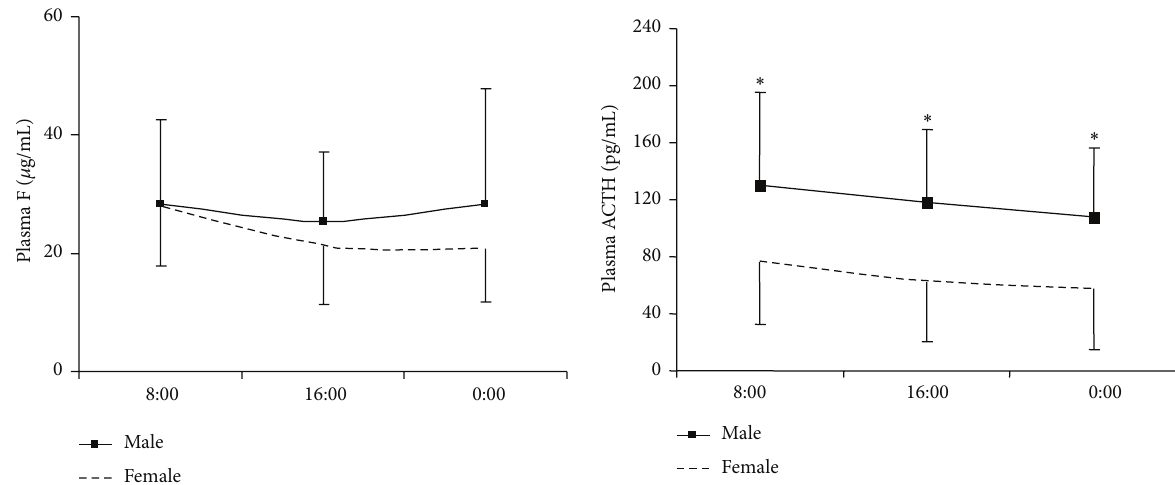
than males (13/73), with a ratio of 4.6 : 1. Most patients were diagnosed at the age of 30. No significant differences in age were found between male and female patients. The 24-hour UFC values ranged broadly across subjects with no significant difference between genders. Male patients had significantly higher BMI, HbA1c, systolic blood pressure, ALT, AST, GGT, and hemoglobin compared to female patients. Comparison of male and female CD patients revealed that ACTH values were